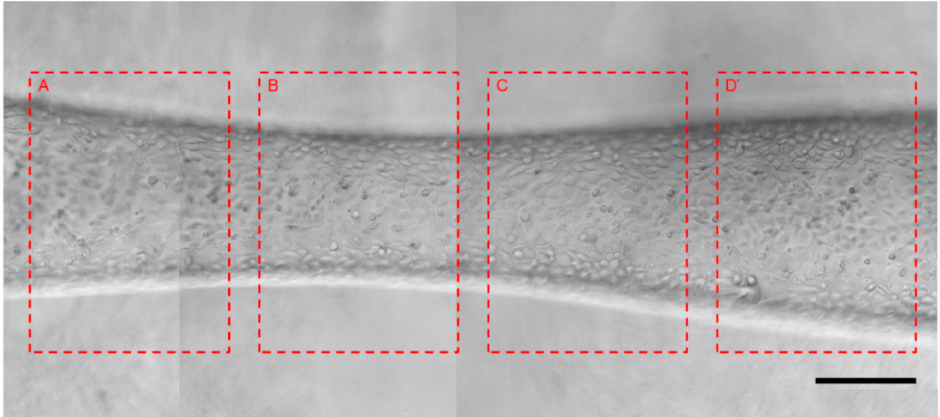
Figure 6. Shear stress caused cell morphology and alignment changes at the bi-conical region: From left to right, ( A ) Gradual narrowing channel region; ( B ) Narrowest channel region; ( C ) Gradual widening channel region; ( D ) Channel diameter widening to original size. Scale bar, 250 µ m. Liquid flow direction, from A to D.